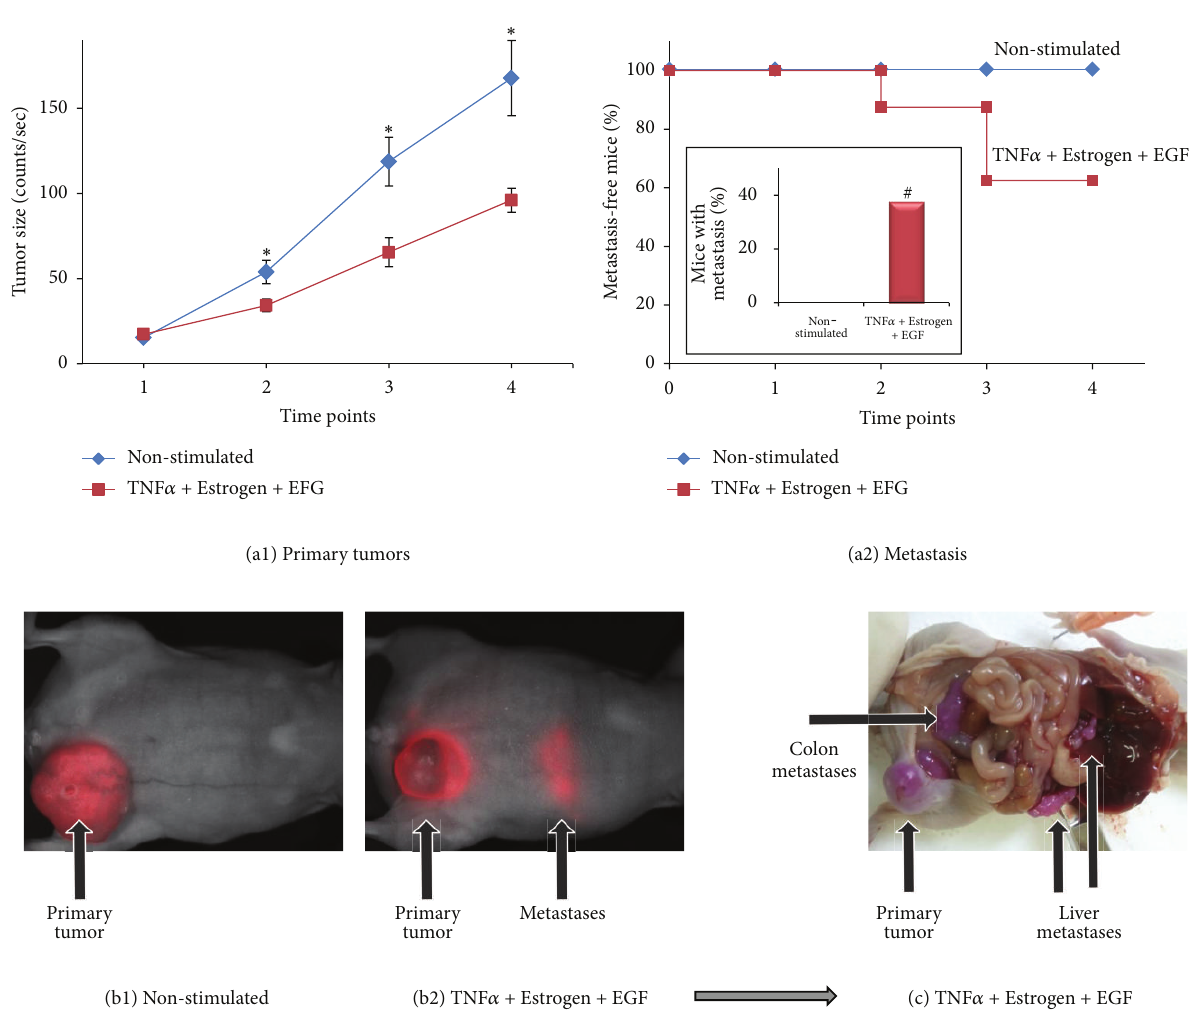
Figure 10: In response to combined stimulation by TNF 𝛼 + Estrogen + EGF, breast tumor cells acquire high metastasizing abilities. mCherry- expressing breast tumor cells were stimulated by TNF 𝛼 + Estrogen + EGF (concentrations as in Figure 1) for three days. Non-stimulated: cells grown with the diluents of the above factors. Following washing, equal numbers of live cells (4 × 10 6 ) were inoculated to the mammary fat pad of mice. Using the CRi Maestro intravital imaging system, tumors and metastases were followed in intact mice at four different time points along the experiments, up to 37 days. (a) Followup of primary tumors in the mammary fat pad and formation of macrometastases. (a1) Sizes of tumors at the mammary fat pads are presented as counts/sec of fluorescence emission, divided by 1,000, obtained at each time point by analyses with the CRi Maestro intravital imaging system. ∗ 𝑃 < 0.05 for differences between the two groups of mice. The figure sums up the results obtained in two experimental repeats showing similar results, with a total 𝑛 = 6 mice in the control group 𝑛 = 8 mice in the group of mice inoculated with cells stimulated with TNF 𝛼 + Estrogen + EGF. (a2) Kaplan-Meier analyses of metastasis-free mice, showing incidence of macrometastases detected by the Maestro device in intact animals in four time points along the experiments, up to 37 days. The figure sums up the results obtained in two experimental repeats showing similar results, with a total of 𝑛 = 6 mice in the control group and 𝑛 = 8 mice in the group of mice inoculated with cells stimulated with TNF 𝛼 + Estrogen + EGF. Inset : the incidence of mice with macrometastases at the end-point of the experiments, determined in intact mice by the Maestro device (38% in the TNF 𝛼 + Estrogen + EGF- stimulated tumor cells versus 0% in the control group, in two independent experiments providing similar results). # Macrometastases were also observed in 2/3 mice in another experiment of TNF 𝛼 + Estrogen + EGF cells (in which control mice were not included). (b) Representative pictures obtained by the Maestro device in intact mice, showing tumor cells (red, mCherry) in both groups of mice. Non-stimulated tumor cells (b1) developed bigger tumors than tumor cells stimulated with TNF 𝛼 + Estrogen + EGF (b2); however, macrometastases were detected only in the group of mice administered with tumor cells stimulated by TNF 𝛼 + Estrogen + EGF (the image was obtained following prolonged excitation of mCherry in the CRi Maestro, in order to visualize the metastases). (c) A representative picture of the macrometastases that have developed in mice inoculated with tumor cells stimulated by TNF 𝛼 + Estrogen + EGF, at the end of the experiment. The image shows the same mouse demonstrated in part (b2). Because of the expression of mCherry, the tumor cells carried a purple color. In this representative mouse, metastases were detected in the liver, colon, and above the